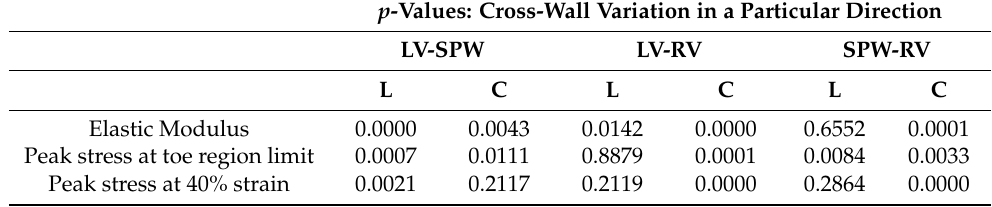
Table 2. Statistical significance test results for cross-wall variations in biaxial mechanical parameters. All statistically significant results in bold type. p -Values: Cross-Wall Variation in a Particular Direction